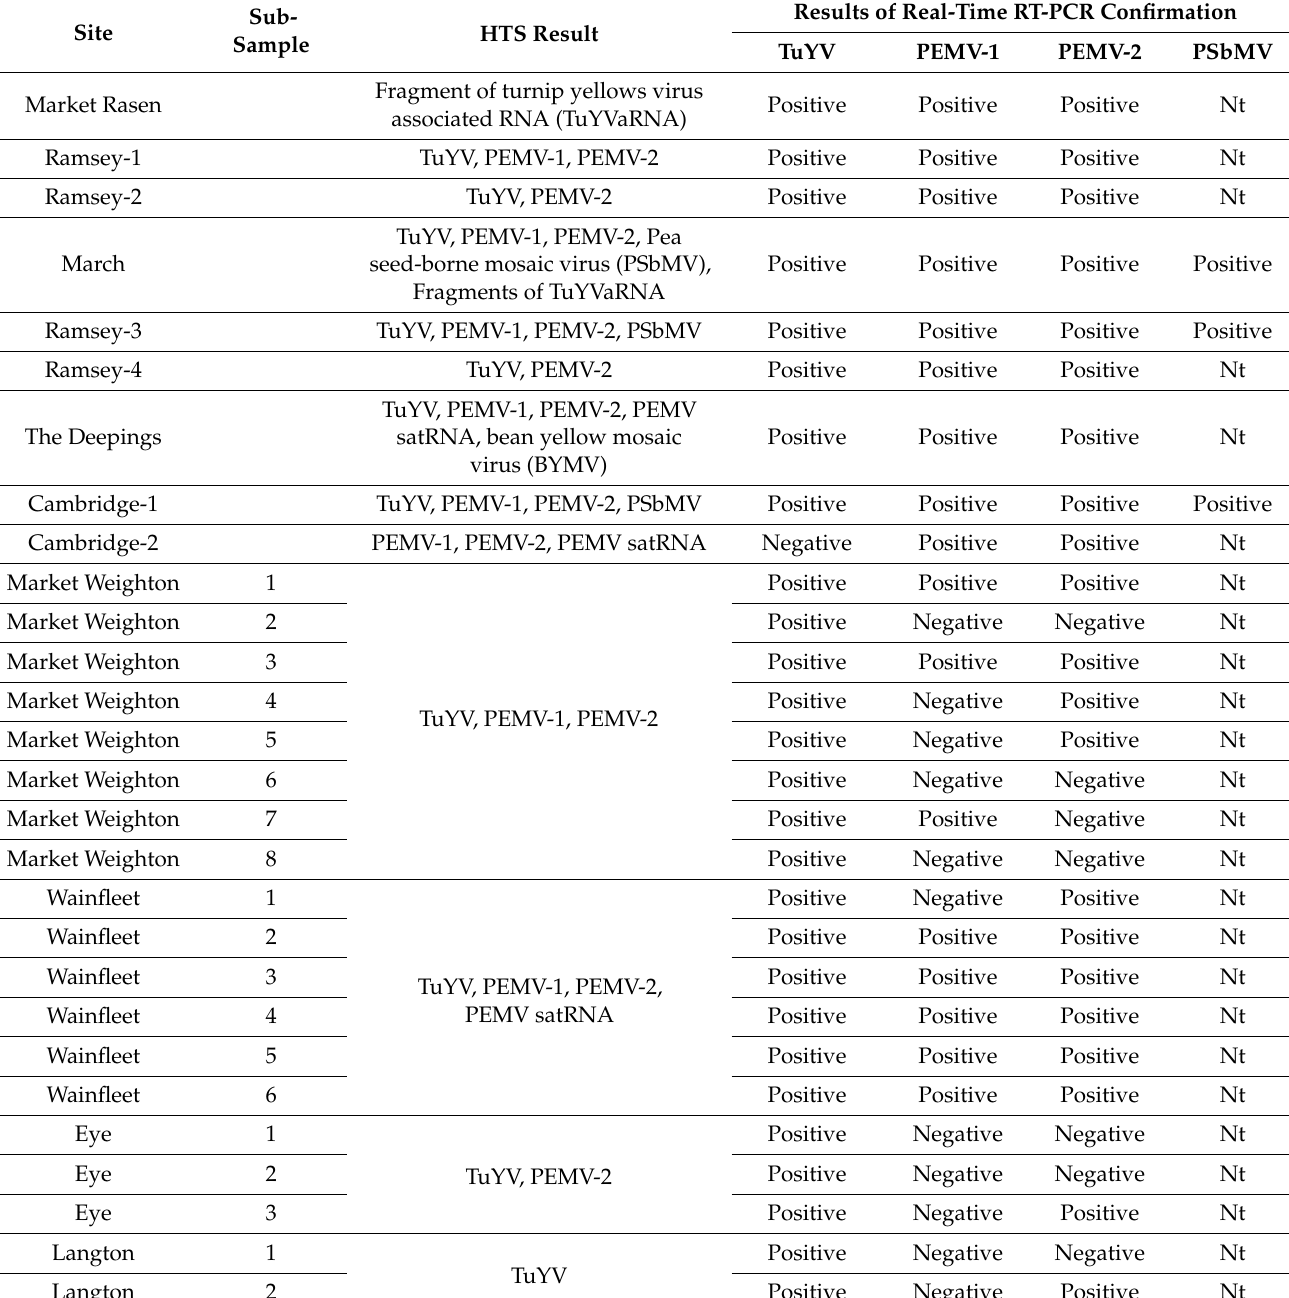
Table 2. Results for testing of symptomatic samples. The nine general surveillance samples from Eastern England were tested by HTS individually, the symptomatic samples from sites were tested as bulks representing the site. Table also shows confirmation of HTS findings by real-time RT-PCR. Samples which were not tested listed as